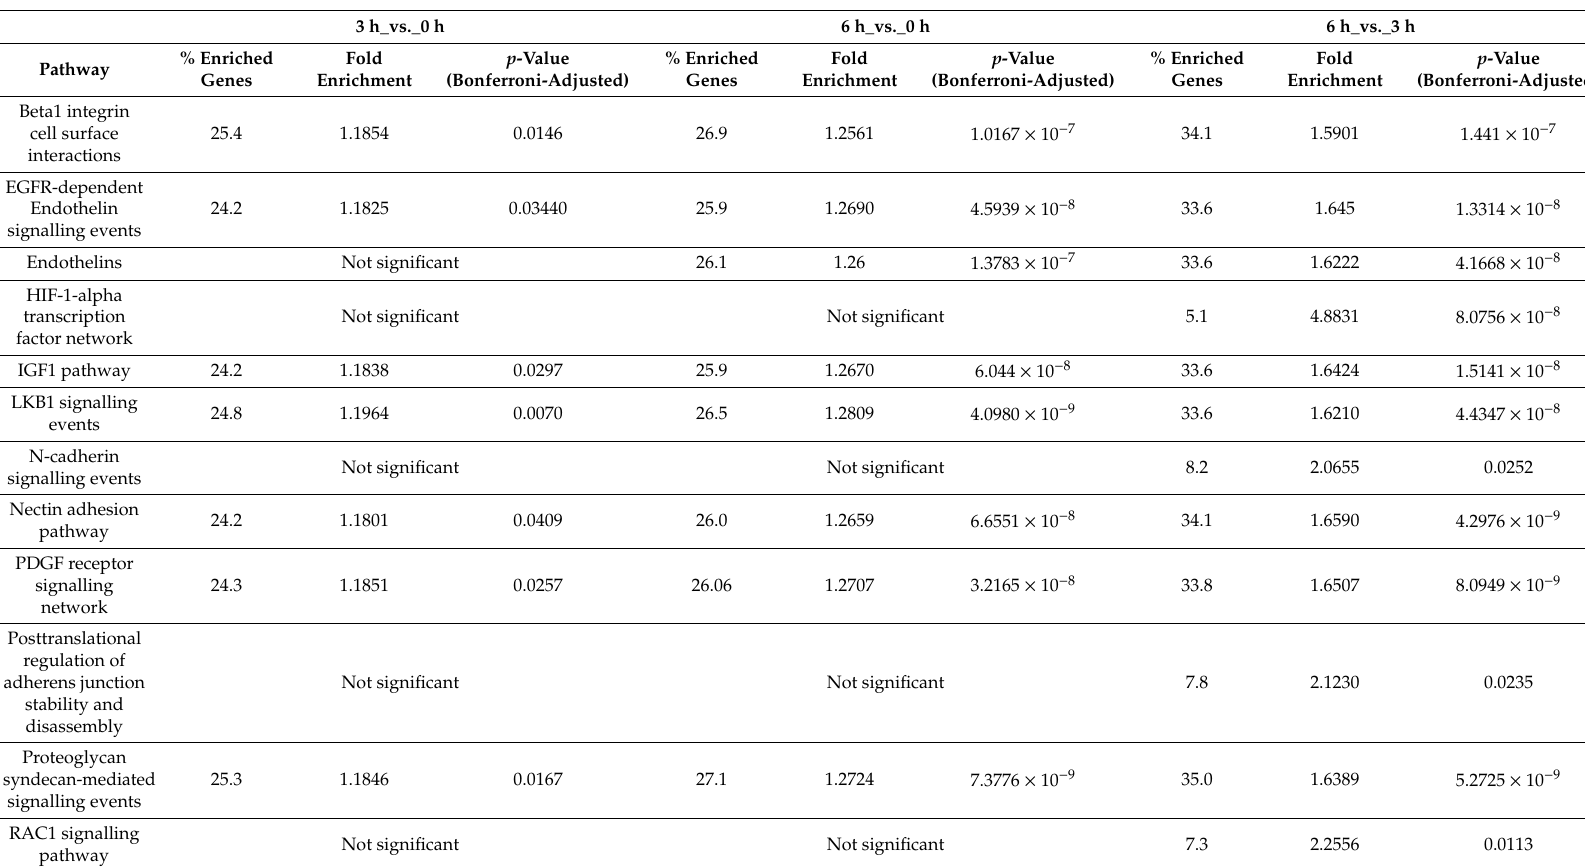
Table 2. Enrichment pathway analysis results. The table shows results obtained by the FunRich tool. Only pathways related to angiogenesis are reported. For each time point, the percentage of enriched genes, the fold enrichment and the Bonferroni-adjusted p -value are reported. Not significant: fold enrichment p -value ≥